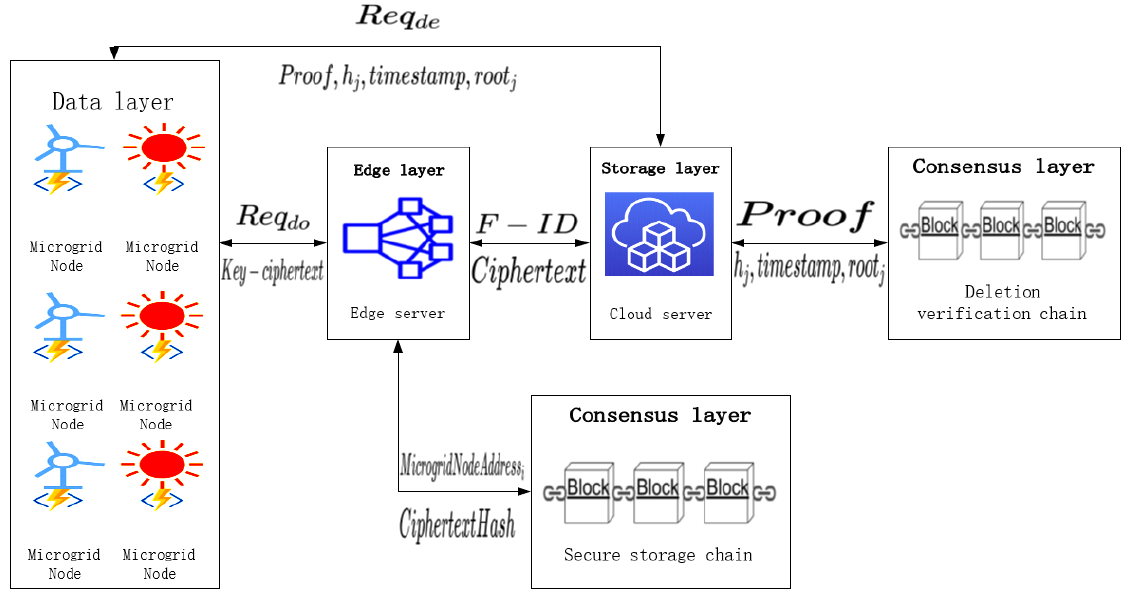
Figure 1. Scheme